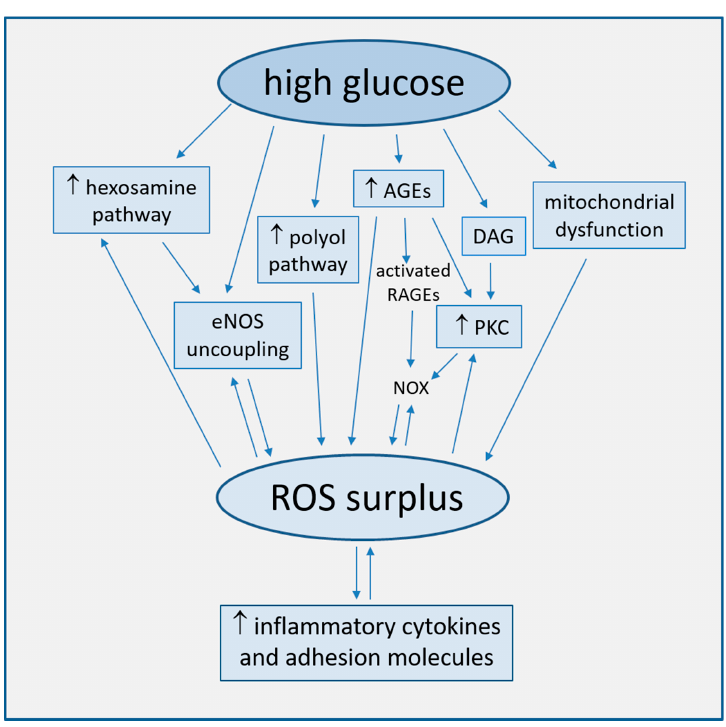
Figure 1. Main mechanisms of high glucose-induced endothelial dysfunction (direct arrows indicate the direction of the pathway, whilst double arrow stands for bidirectional pathway).